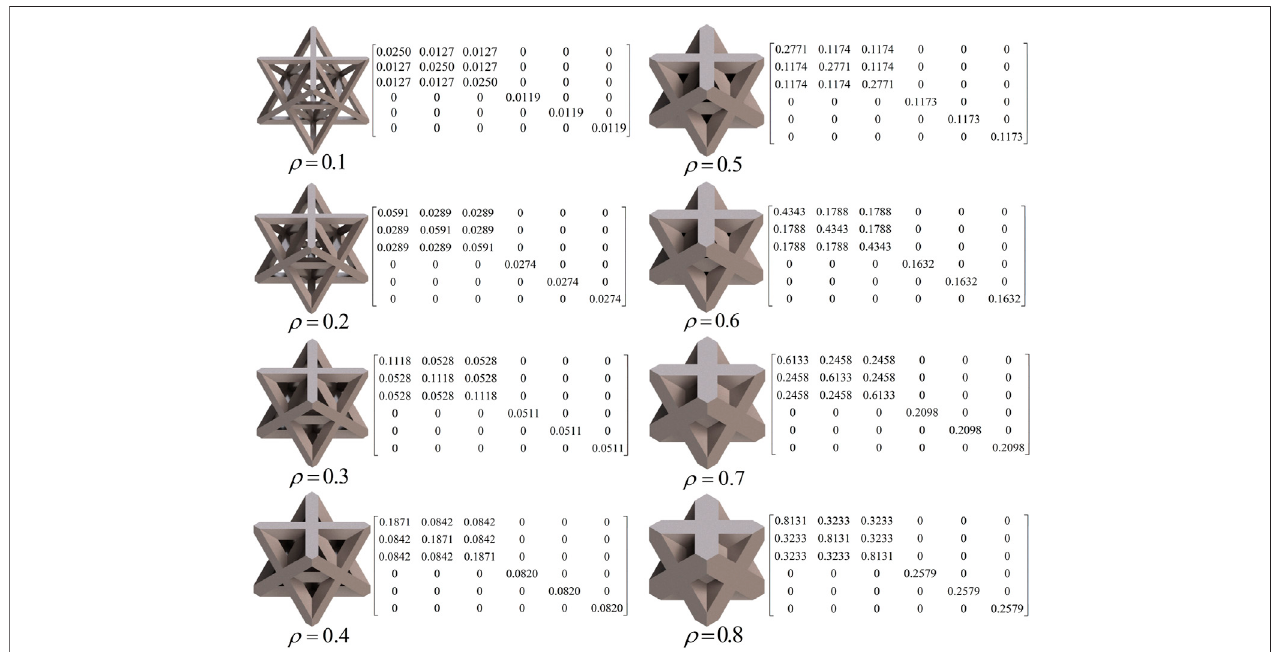
FIGURE 6 | Elastic matrix of an octet-truss cell with relative density ranging from 0.1 to 0.8.